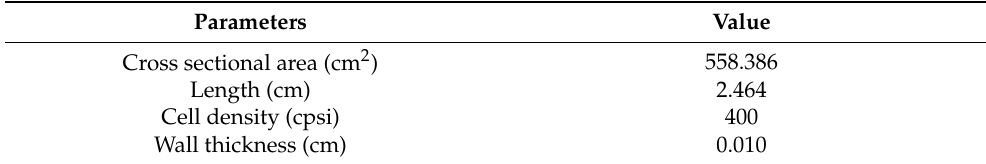
Figure 3. Schematic diagram of SCR model. ( a ) SCR physical model. ( b ) SCR one-dimensional model. Table 5. Parameters of SCR mode.